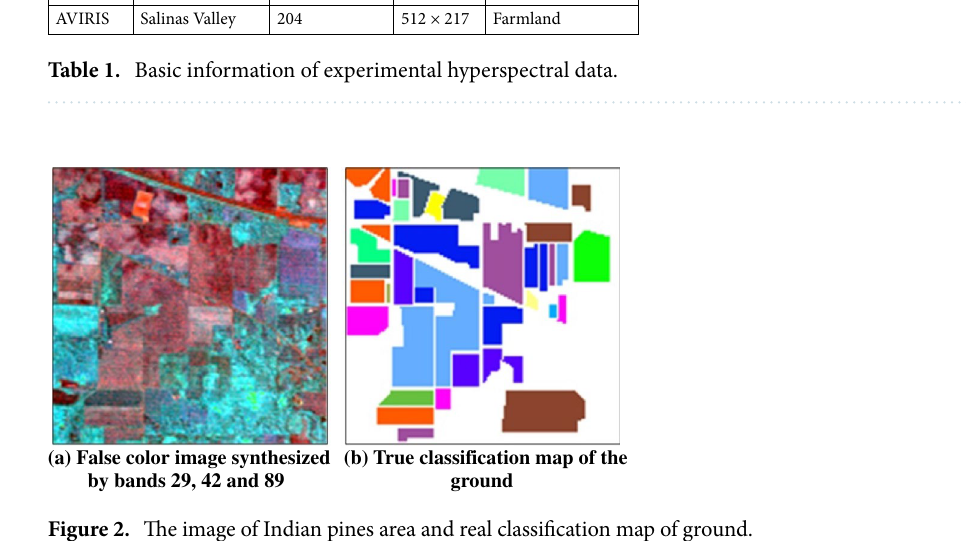
Figure 2. The image of Indian pines area and real classification map of